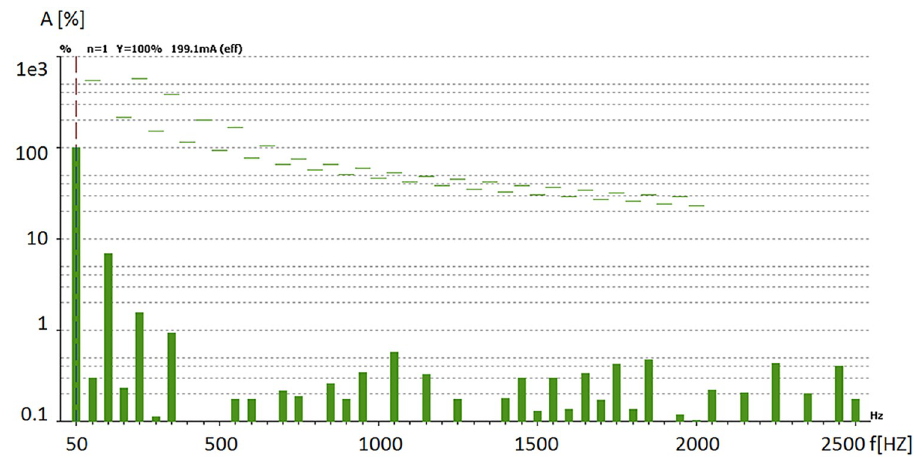
Fig 11. Higher order harmonics generated by the linear power supply.